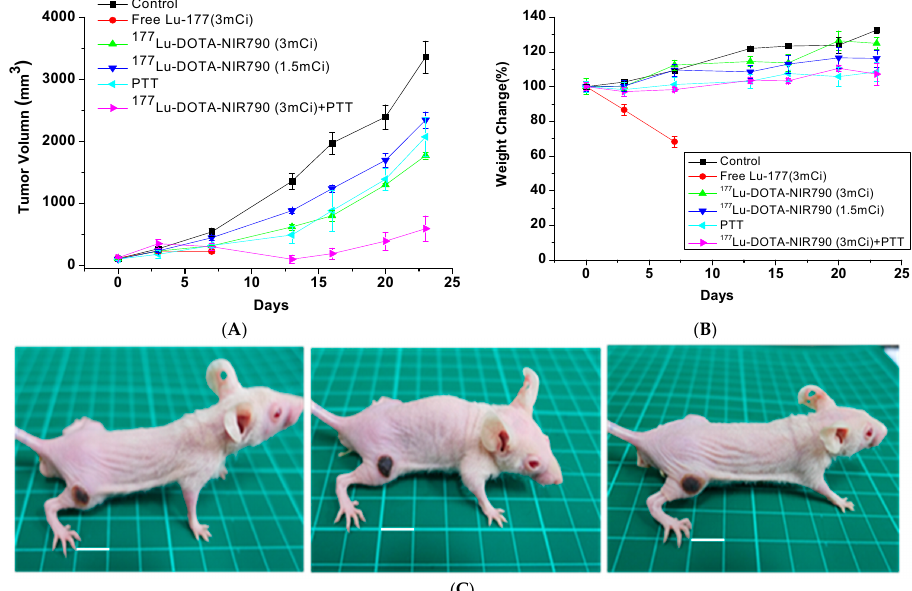
Figure 8. Anti-tumor effect of multi-functional tumor theranostics probes. ( A ) Tumor growth inhibition of photothermal therapy (PTT) combined with targeted radionuclide therapy by 177 Lu-DOTA-NIR790 ( n = 6 per group) ( B ) body weight changes, and ( C ) Representative mice treated with 177 Lu-DOTA-NIR790 and NIR irradiation for 5 min were photographed. The scale bar is 10 mm.